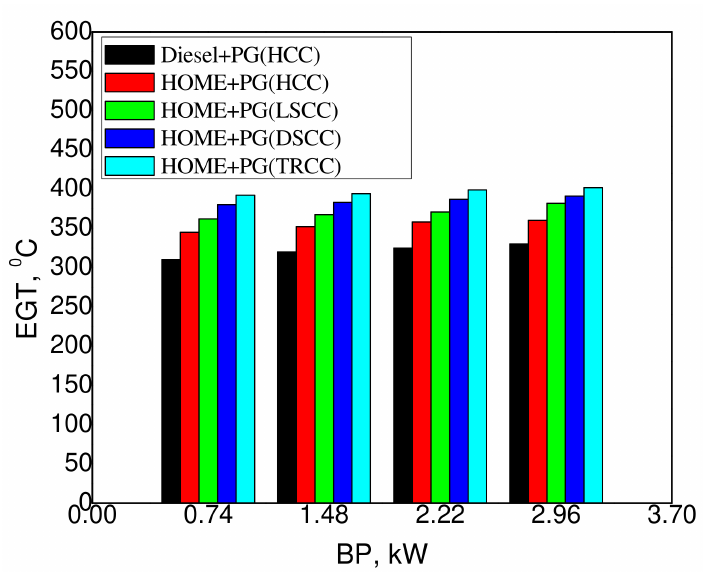
Figure 5. Effect of the combustion chamber type on